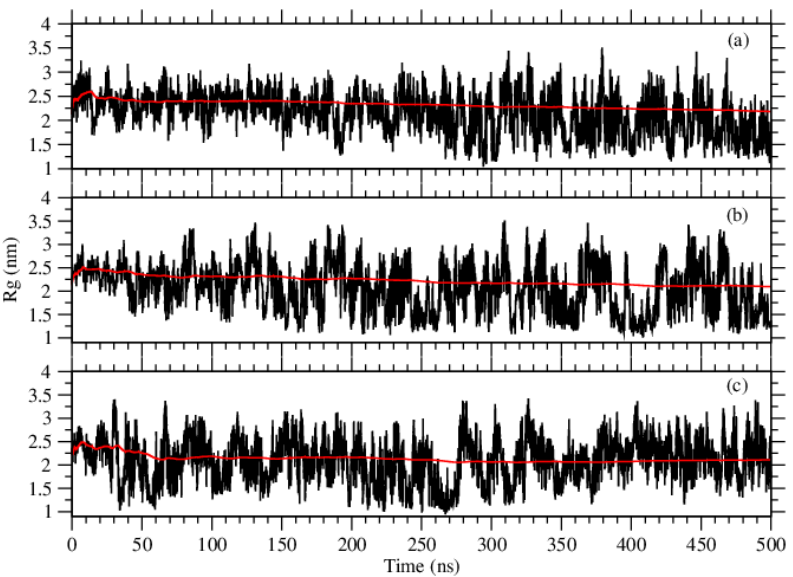
Figure 5. The values of radius of gyration calculated over the trajectories for the molecules of ( a ) Phe, ( b ) Tyr, and ( c ) Trp. Red curves show the moving averages.